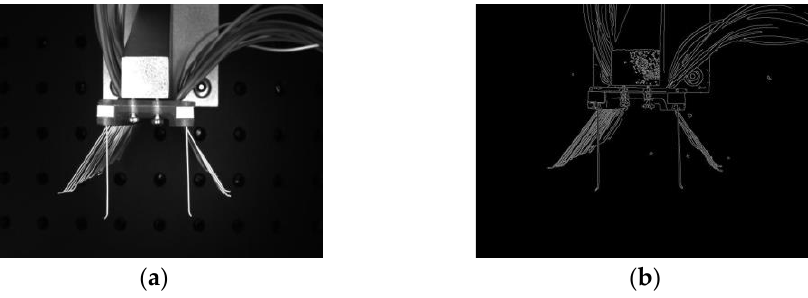
Figure 11. Edge detection comparison image: ( a ) Original image and ( b ) Canny edge detection.